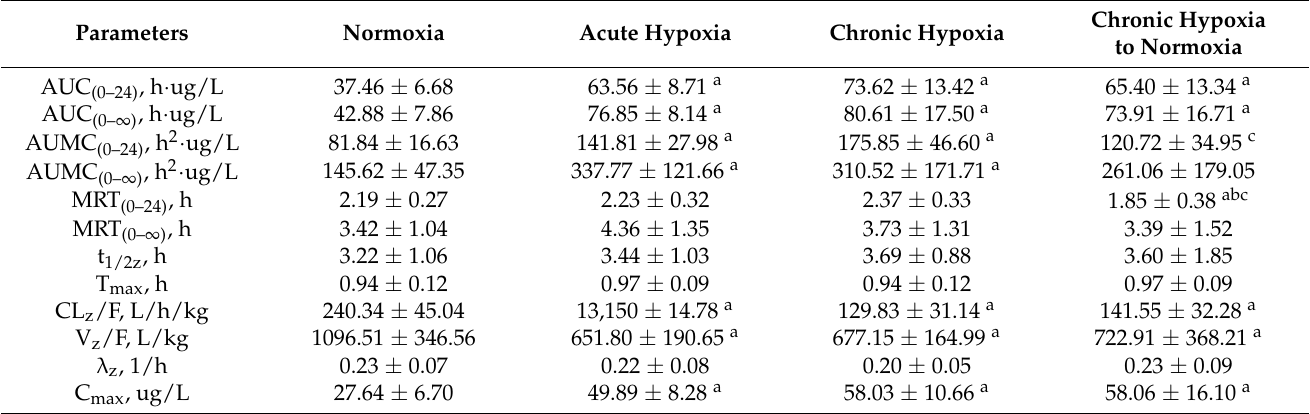
Table 3. Pharmacokinetic parameters of sildenafil in rat plasma after exposure to high-altitude hypoxia.